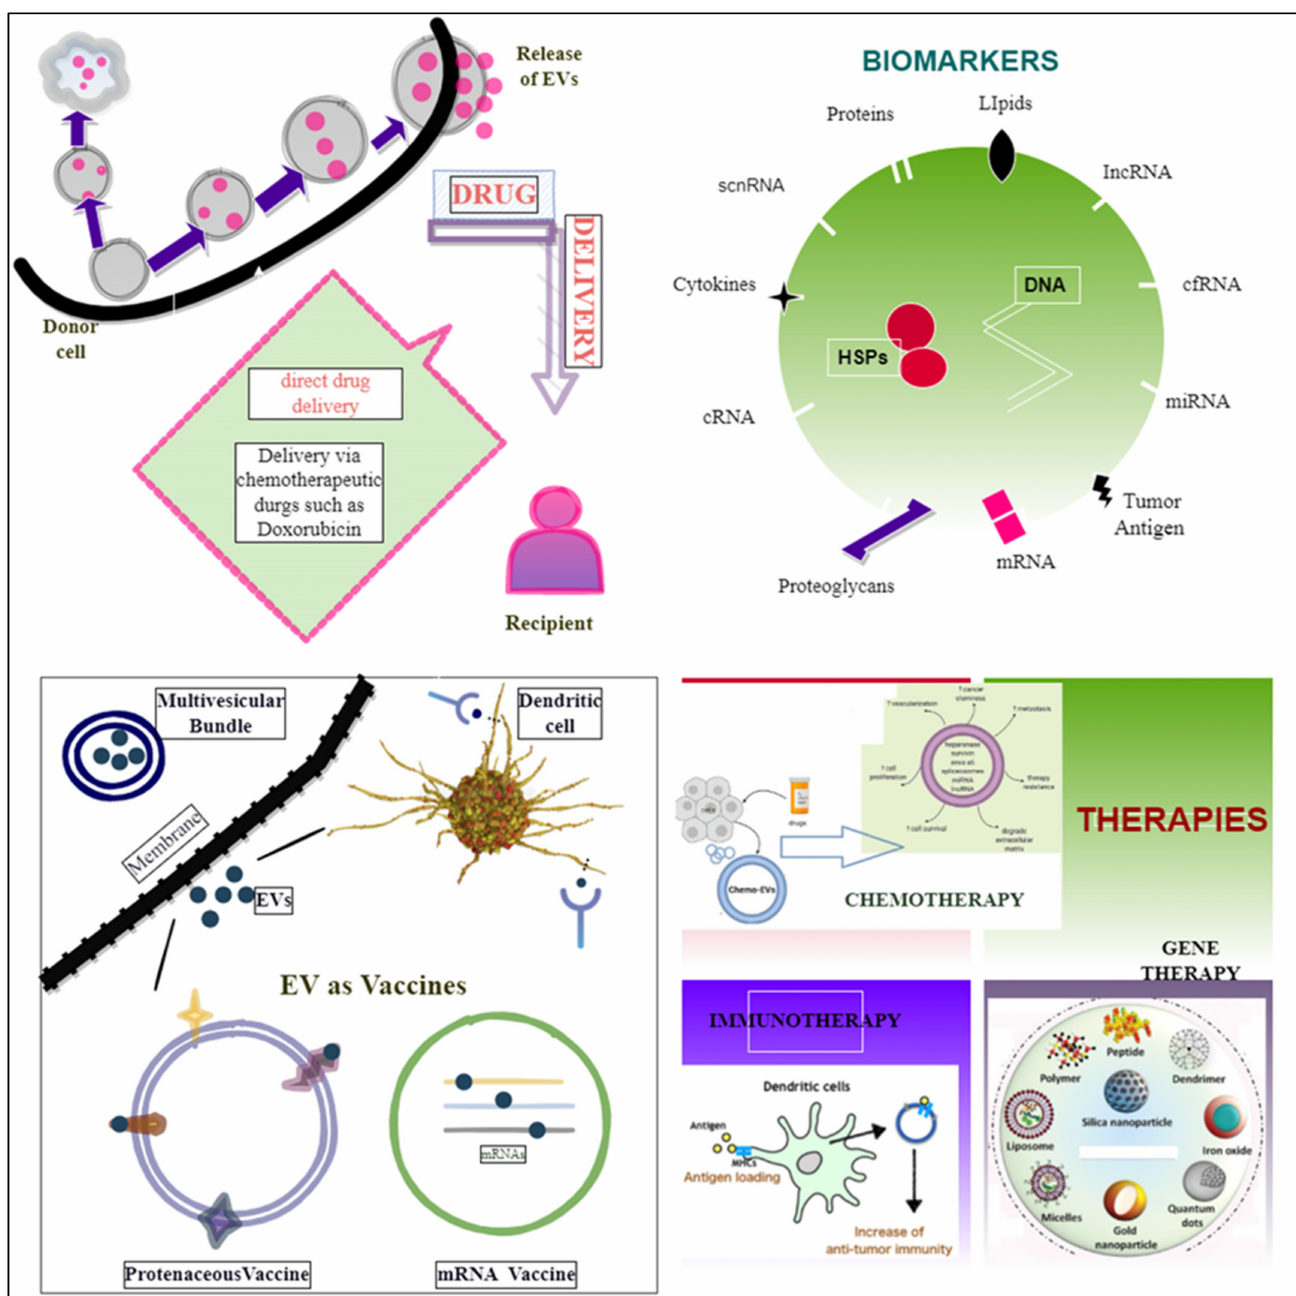
Figure 3. Diagrammatic representation revealing EVs’ role as biomarkers, vaccines, and in different